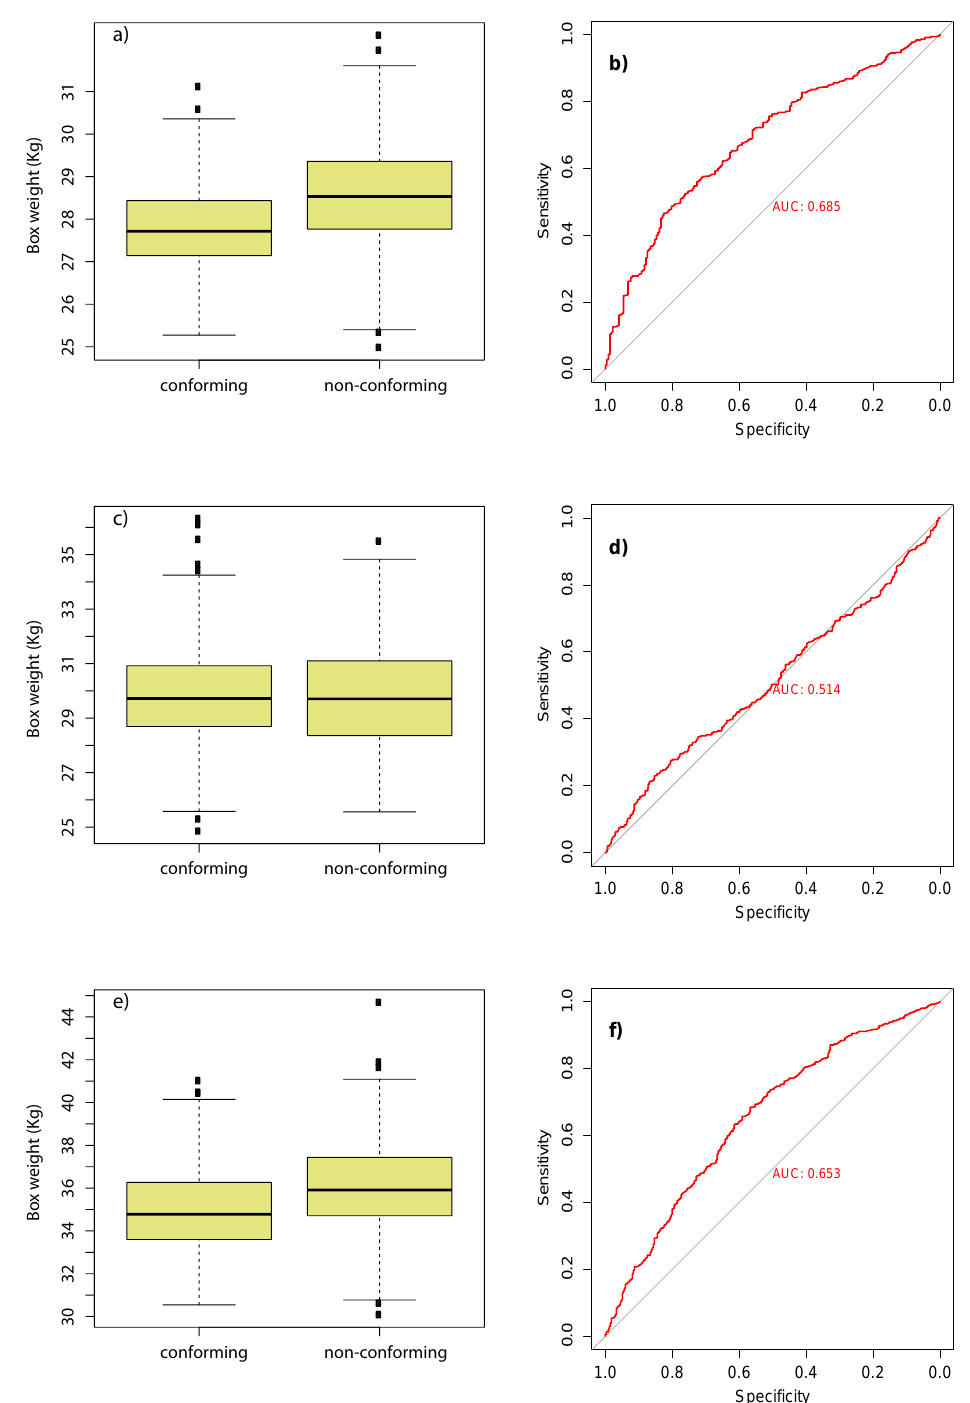
Figure 5. Conformity assessment of the container boxes (left column) and evaluation of the ROC curve (right column) in the ports of ( a , b ) Melinka (UMLS = 6.5 cm), ( c , d ) Quellón (UMLS = 6.0 cm), and ( e , f ) complete area excluding Melinka (UMLS = 6.0 cm), according to the simulation of 1000